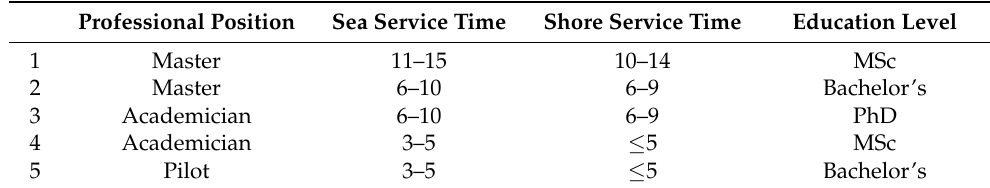
Figure 1. Fault tree diagram.